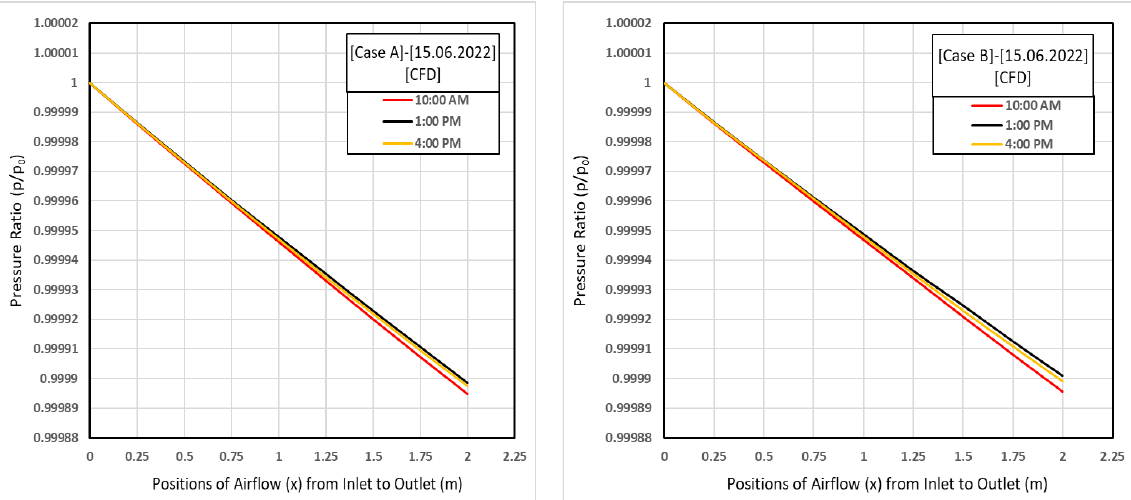
Figure 19. CFD airflow pressure ratio results for the Case A and Case B FPSAHs tested at various time intervals.